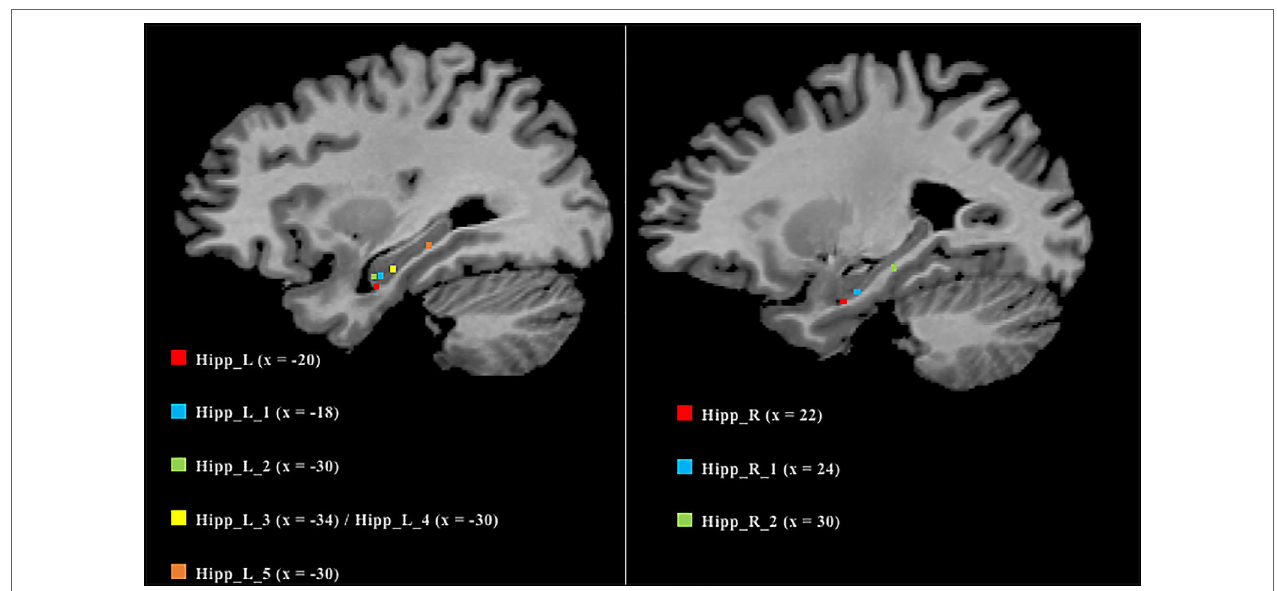
FigUre 6 | Anatomical localization of the nodes in the hippocampi. Coordinates refers to Talairach space (right sagittal slice x = 25, left x = 30). Nodes are numerically labeled according to a rostrocaudal criterion.